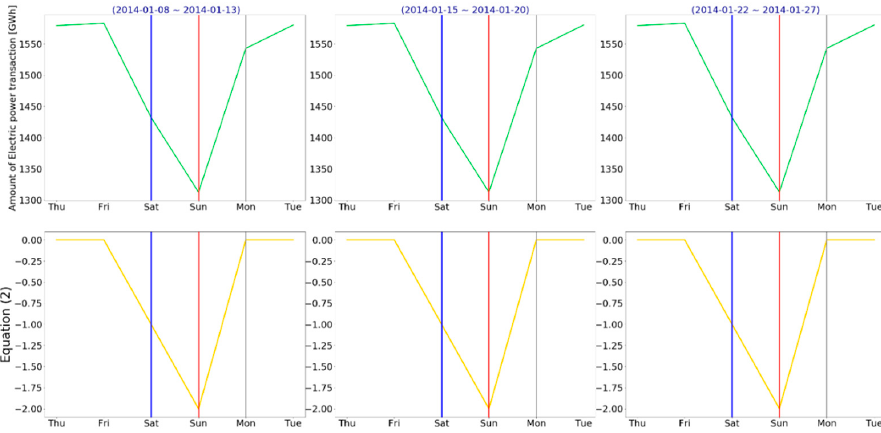
Figure 13. Graph applying power transaction and Equation (2) on different weeks.